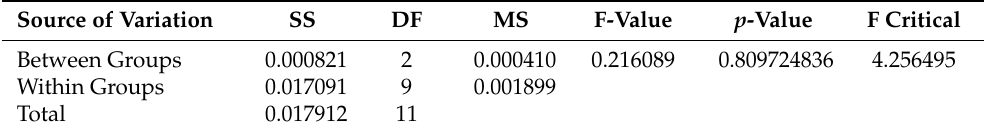
Table 9. ANOVA: Time Single Factor